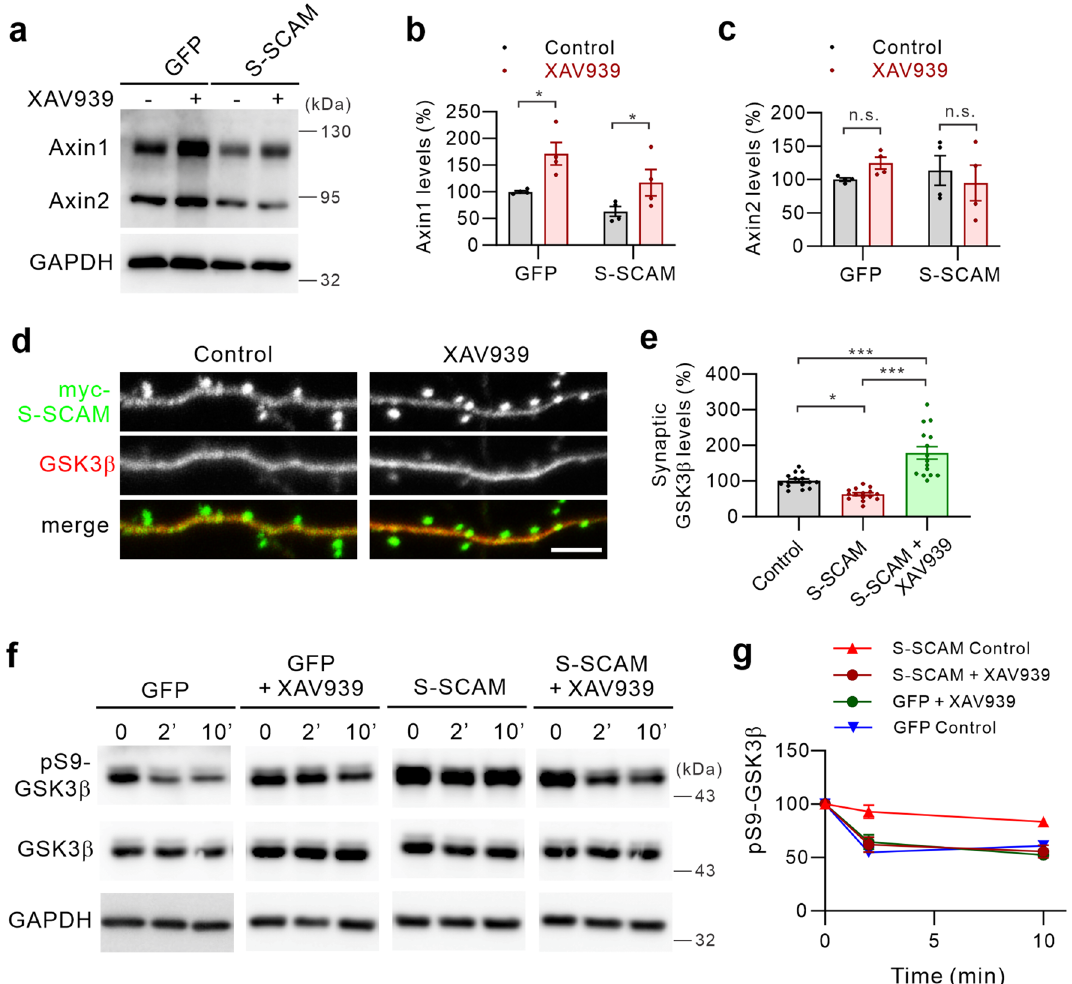
Figure 4. Axin stabilization restores synaptic GSK3β levels and its temporal regulation during Chem-LTD. ( a – c ) Effect of XAV939 (5 mM) on the total protein levels of Axin1 and Axin2 in GFP- or S-SCAM-overexpressing cultured hippocampal neurons. Representative immunoblots ( a ), and quantification of the data for Axin1 ( b ) and Axin2 ( c ). n = 4 per group. * p < 0.05, unpaired t -test. ( d , e ) Effect of XAV939 on synaptic GSK3β levels in myc-S-SCAM overexpressing neurons. Representative images ( d ), and quantification of the data ( e ). n = 15 per group. One-way ANOVA, F (2,42) = 29.91, p < 0.001. Tukey’s multiple comparison test: *** p < 0.0001, * p < 0.05. ( f – g ) Effect of XAV939 on the GSK3β activation during Chem-LTD. Representative immunoblots ( f ) and quantification of the data ( g ). n = 3 per group. * p < 0.05, unpaired t -test with Welch’s